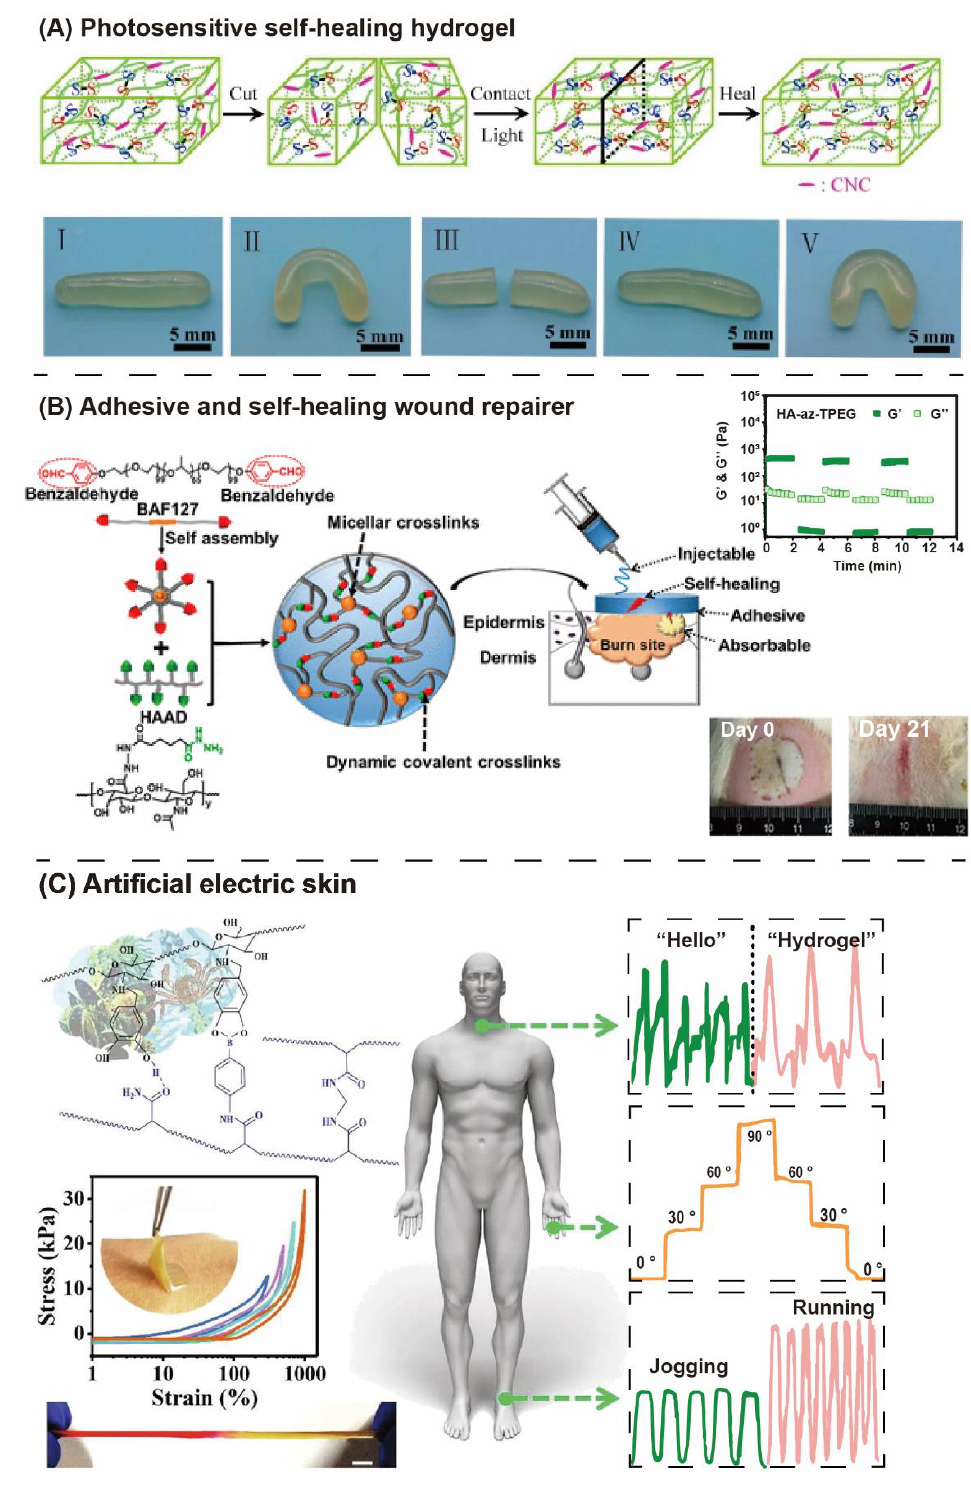
Figure 6. Applications of functional self-healing dynamic covalent hydrogels. ( A ) cellulose-based self-healing hydrogel based on disulfide bond photoresponse [131]. ( B ) Ha-AZ-F127 hydrogel with dynamic covalent chemically and micellar physically double-crosslinked networks was applied in the deep partial-thickness burn model to promote burn wound repair [133] Copyright © 2018, American Chemical Society. ( C ) Biocompatible ionic gels with shape-adaptability and skin adherence were used as artificial electric skin [138]. Copyright © 2020 Elsevier B.V.